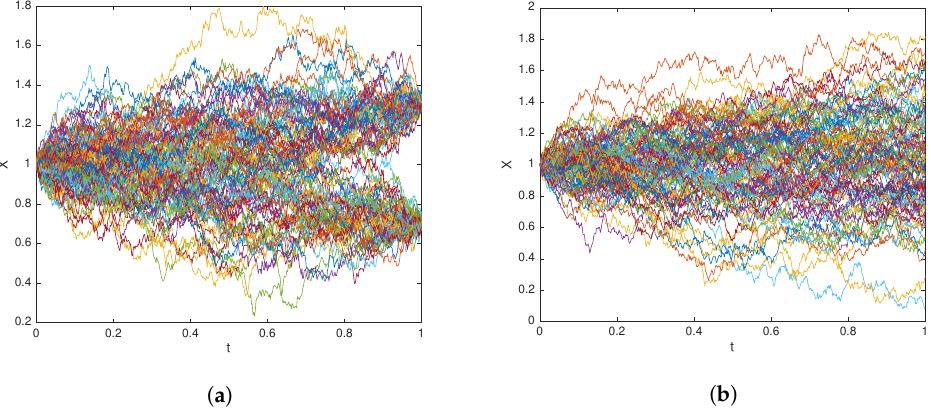
Figure 1. Path simulation of (4) with the prior belief on the future log-price following ( a ) two-point discrete distribution and ( b ) normal distribution. Parameters: ( a ) δ u = 0.3, δ d = − 0.3, p u = 0.5, p d = 0.5; ( b ) µ = 0, σ D = 0.3. Common parameters: X 0 = 1, T = 1, σ = 0.4.